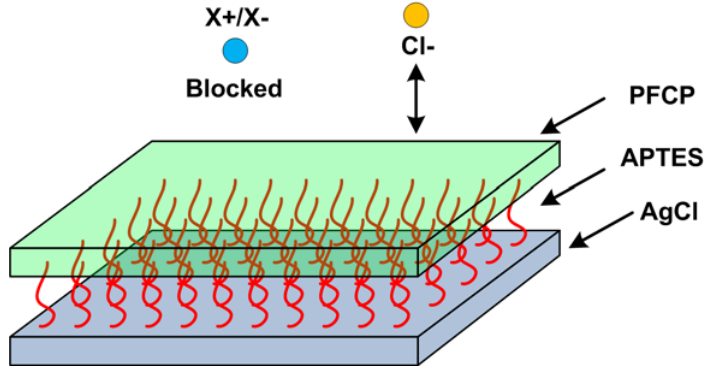
Figure 11. Blocking cross-contamination with self-assembled molecules [78].